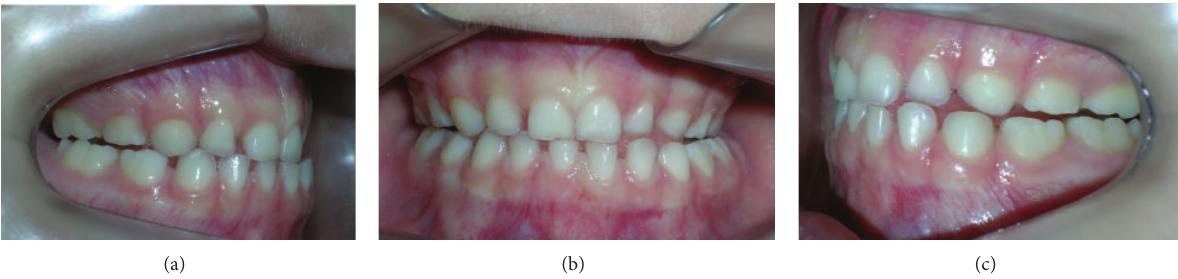
Figure 3: Clinical aspects after oclusal adjusts. (a) Right side, (b) front view, and (c) left side.